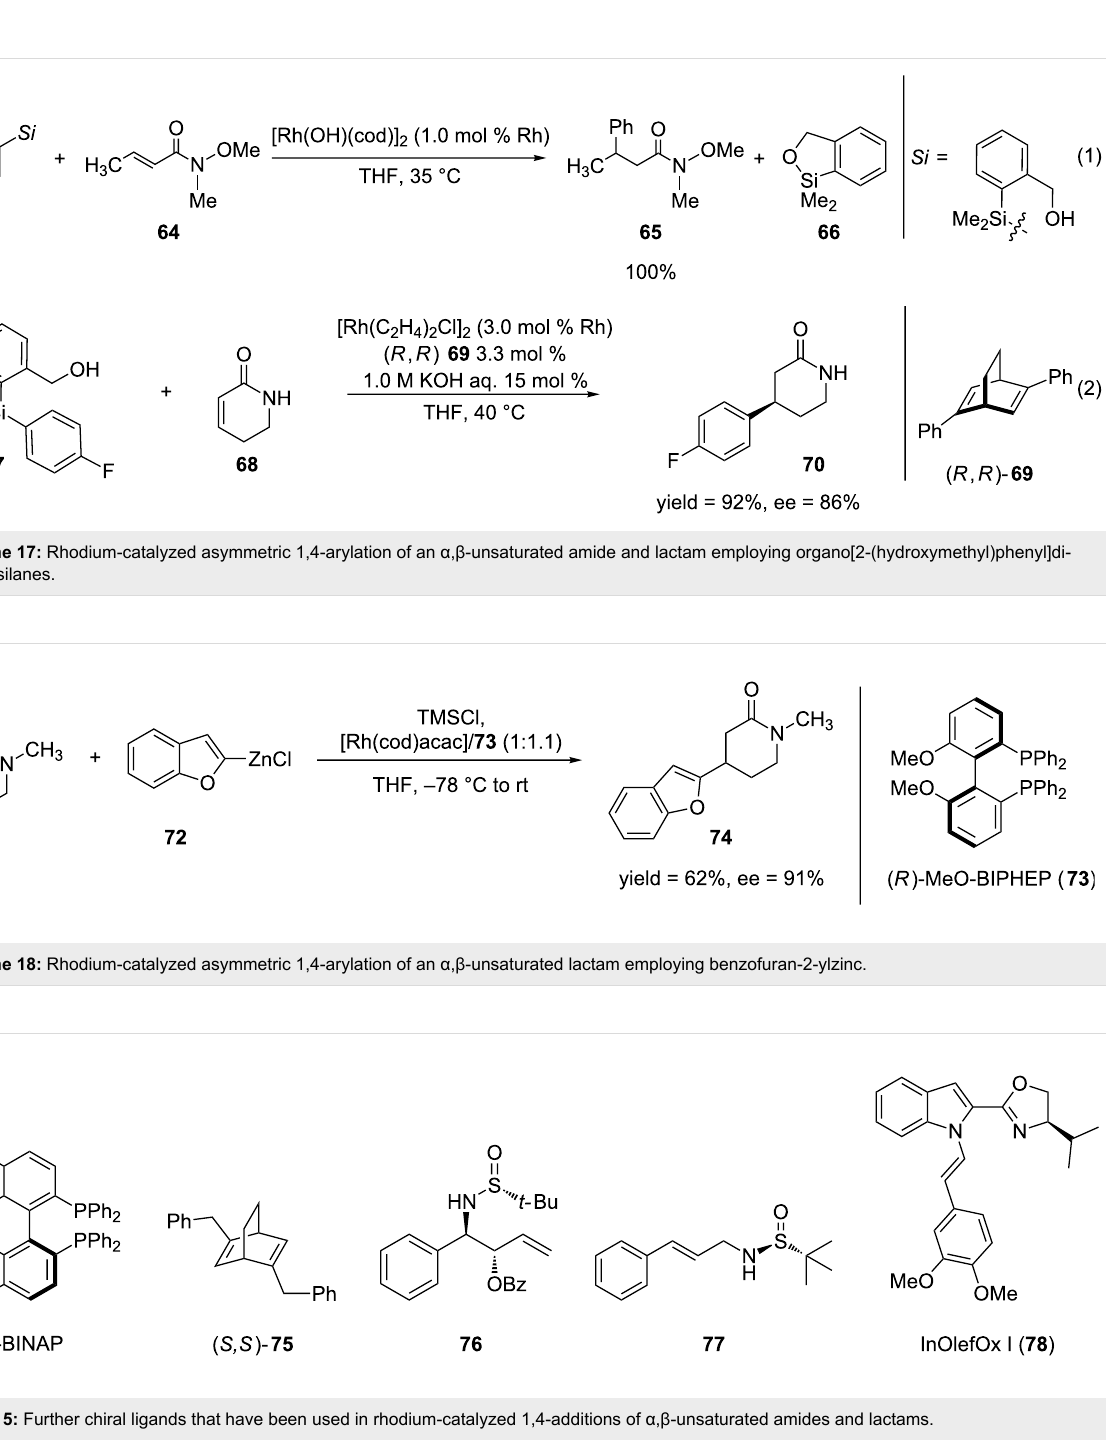
Besides the previously referenced examples, ( S )-Binap has also been used in the 1,4-addition of aryltrialkoxysilanes to a series of α , β -unsaturated amides [154]. In 2005, Hayashi and co-workers developed conditions for the 1,4-arylation of various Weinreb amides, which utilized ( S , S )- 75 as the chiral ligand [130]. Xu and co-workers developed various N -sulfinyl homoallylic amines ( 76 ) [160] and N -cinnamyl sulfonamides